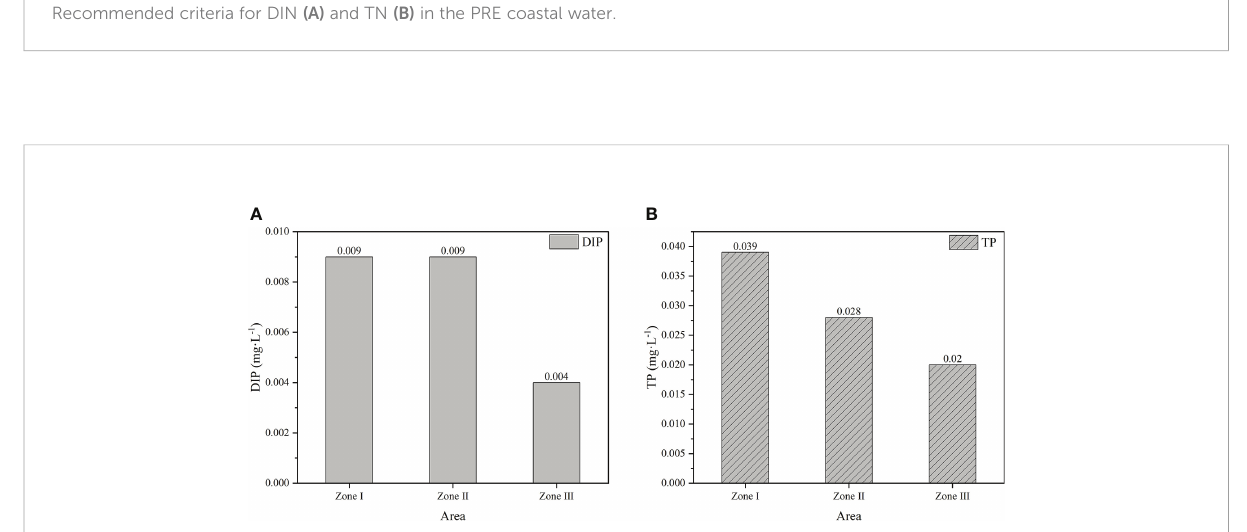
FIGURE 7 Recommended criteria for DIP (A) and TP (B) in the PRE coastal